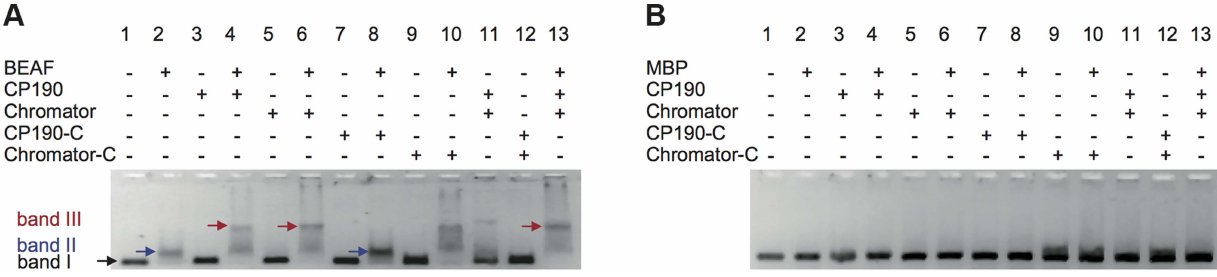
Figure 4. Insulator factors interact upon DNA binding. (A) Native agarose band-shift assay of BEAF32-DNA tudor , and higher order complexes. Lane 1, 476 bp DNA tudor ; lane 2, DNA tudor incubated with BEAF32; lane 3, DNA tudor incubated with CP190; lane 4, DNA tudor incubated with BEAF32 and CP190; lane 5, DNA tudor incubated with Chromator; lane 6, DNA tudor incubated with BEAF32 and Chromator; lane 7, DNA tudor incubated with CP190-C; lane 8, DNA tudor incubated with BEAF32 and CP190-C; lane 9, DNA tudor incubated with Chromator-C; lane 10, DNA tudor incubated with BEAF32 and Chromator-C; lane 11, DNA tudor incubated with CP190 and Chromator; lane 12, DNA tudor incubated with CP190-C and Chromator-C; lane 13, DNA tudor incubated with BEAF32, CP190 and Chromator. Band 1 represents DNA tudor . Band 2 represents the complex between BEAF32 and DNA tudor . Band 3 represents the BEAF32/DNA tudor complex super-shifted by binding of CP190, Chromator, Chromator-C, or the addition of both CP190 and Chromator. The shift of band 1 requires the presence of BEAF32. Protein concentrations used: BEAF32 (400 nM), CP190 (50 nM), CP190-C (50 nM), Chromator (100 nM), Chromator-C (100 nM). (B) Native agarose band-shift assay of MBP-DNA tudor . This experiment used the same protein mixes and concentrations as those used in (A) but replacing BEAF32 by MBP. No shifted band is